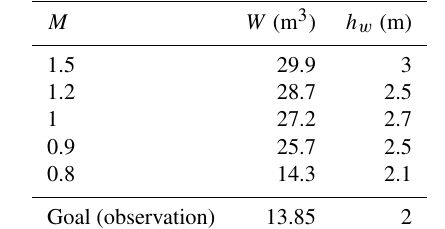
Table 2. Snow properties adopted in the MPM modelling of the flows for three typical flow